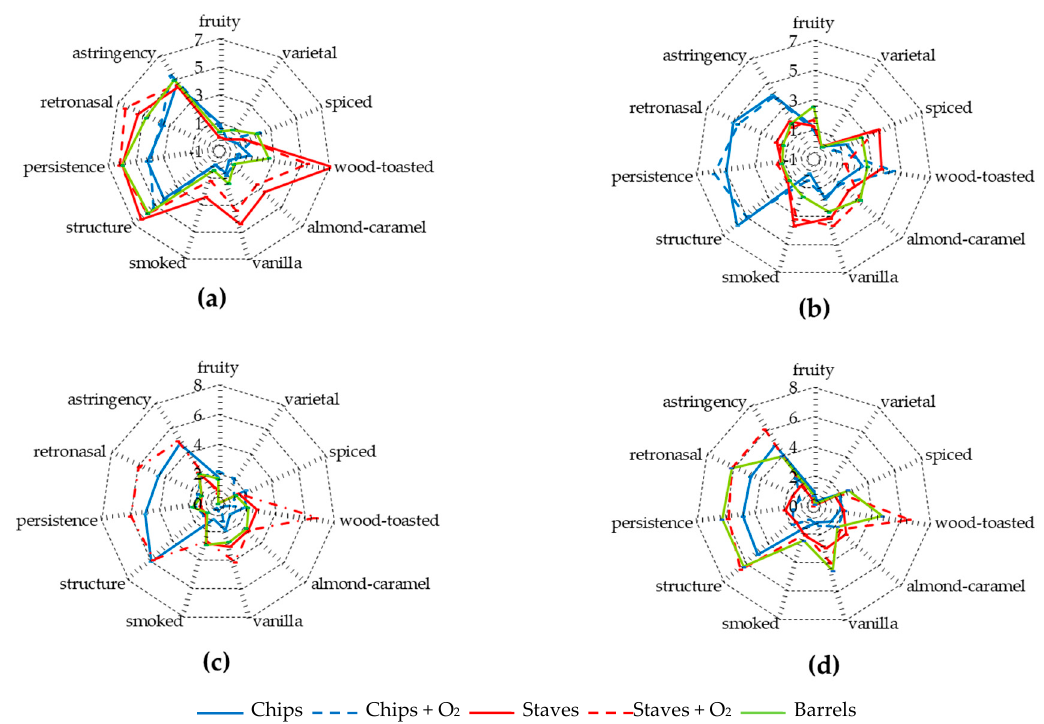
Figure 10. Sensory profiles of wines at: ( a ) 2 months; ( b ) 4 months; ( c ) 6 months; and ( d ) 12 months.